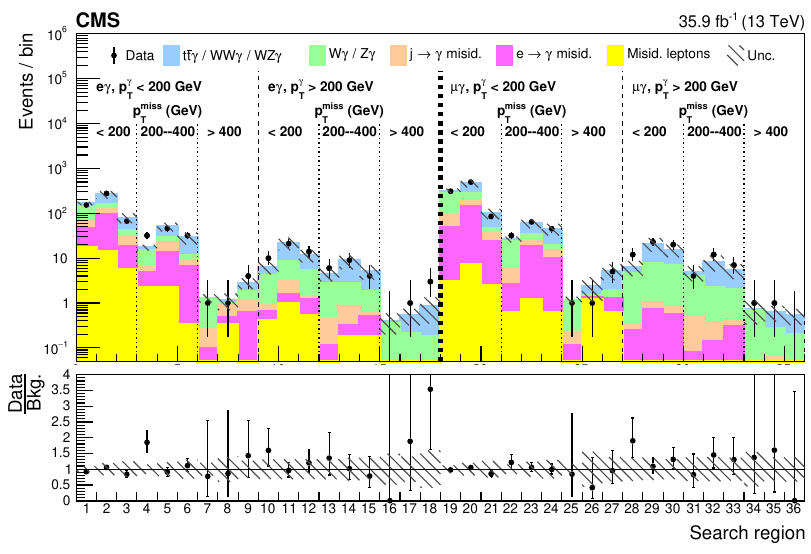
Figure 5 . The number of data events (points) and predicted background events (shaded his- tograms) for the 18 search regions in p miss , H T , and p (cid:13) (separated by dashed vertical lines) in the T T e (cid:13) (regions 1{18) and the (cid:22)(cid:13) (regions 19{36) channels. For each p miss range, the (cid:12)rst, second, and T last bins correspond to the H T regions 0{100, 100{400, and > 400 GeV, respectively. The lower panel displays the ratio of the data to the background predictions. The vertical bars on the points show the statistical uncertainty in the data, and the hatched areas give the quadrature sum of the statistical and systematic uncertainties in the simulated